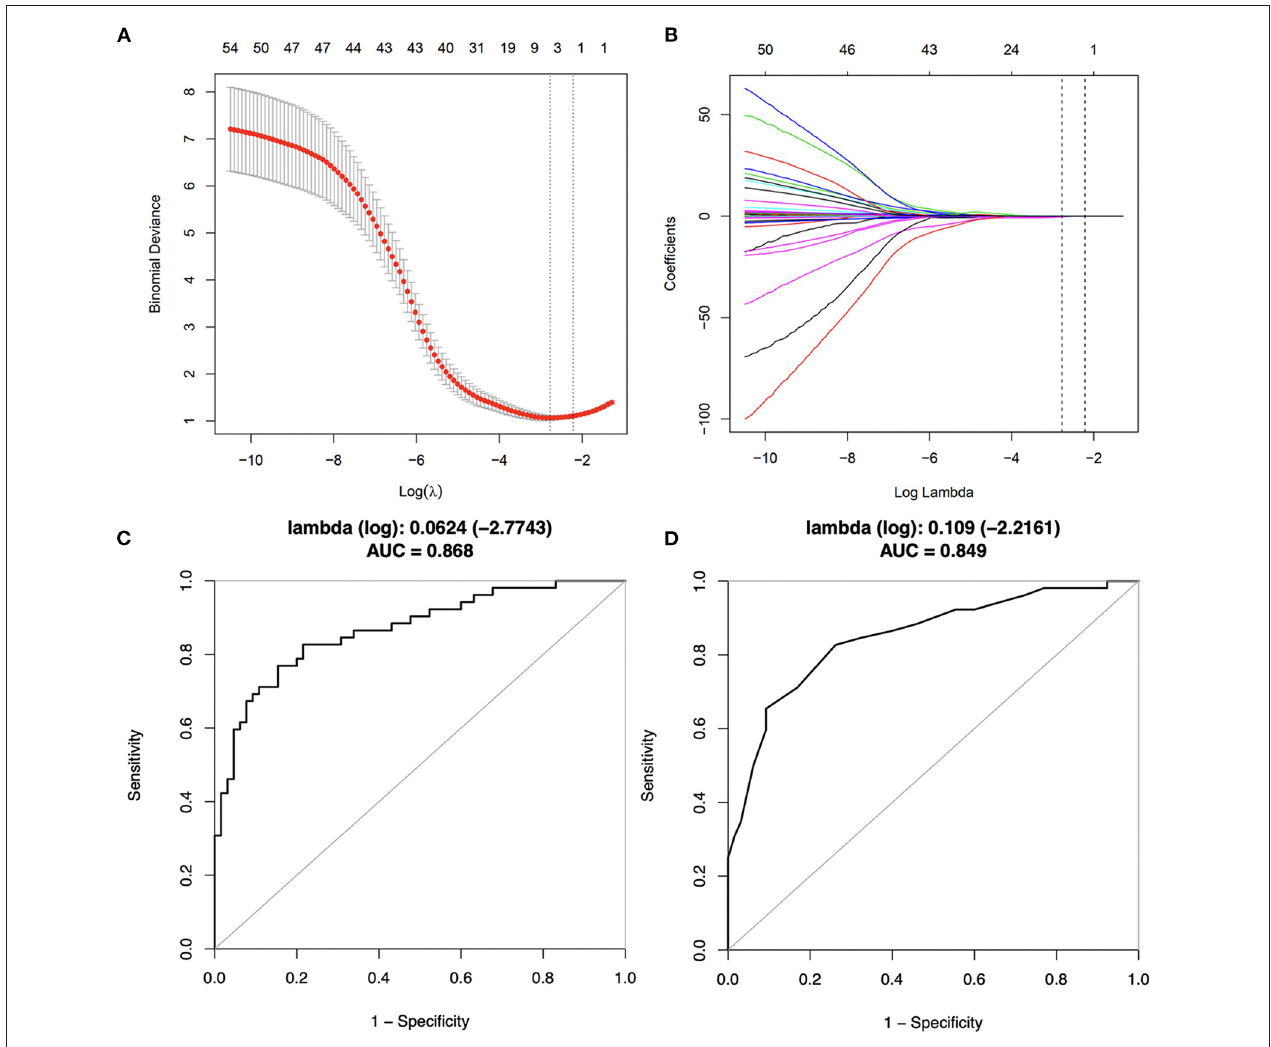
FIGURE 3 | Predictive variables selection using Lasso regression with 10-fold cross-validation. (A) Binomial deviance was plotted vs. log (lambda). A total of 46 candidate variables were included. Dotted lines are depicted at the optimal values by minimum criteria (lambda. min, left vertical dotted line) and 1-SE criteria (lambda.1se, right vertical dotted line). (B) Coefficients plots were produced against the log (lambda) sequence, profiling all the clinical features. (C) Corresponding ROC curve of model 1, with a minimum lambda of 0.0624 and an AUC value of 0.868. (D) Corresponding ROC curve of model 2, with an optimal lambda of 0.109 and an AUC value of